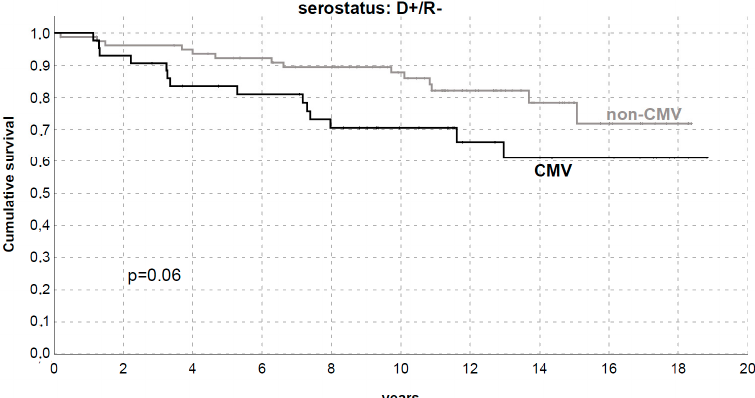
Figure 3. Death-censored graft survival by CMV replication/disease in the first year after transplantation with different donor and recipient CMV serostatus.